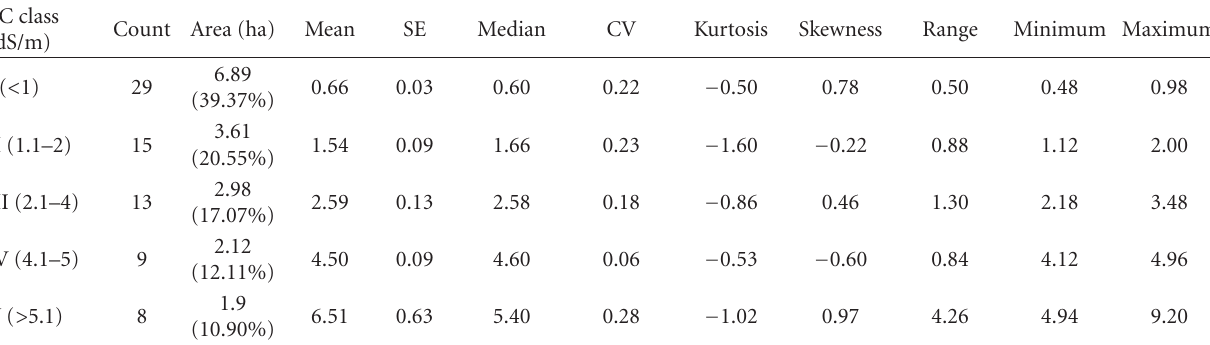
Table 4: Five classes of EC 1:1 , number of count in each class, area, mean, standard error (SE), median, coe ffi cient of variation (CV), kurtosis, skewness, range, minimum (min), and maximum (max) at 20–40 cm depth during